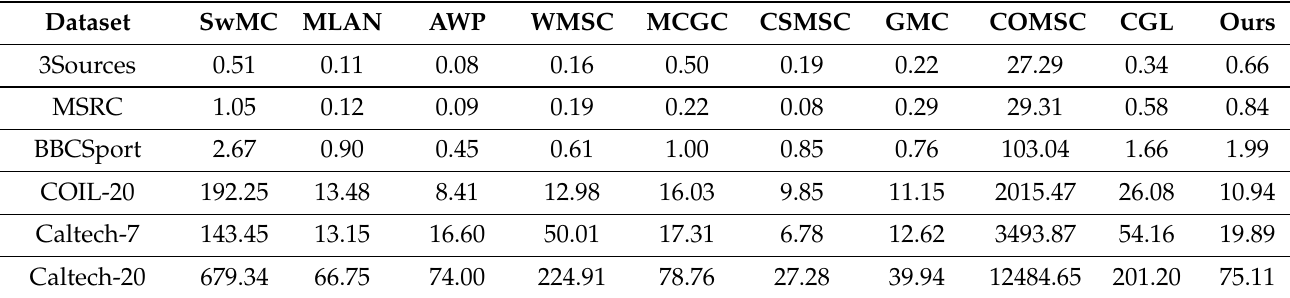
Table 4. Comparison of computational time (seconds).